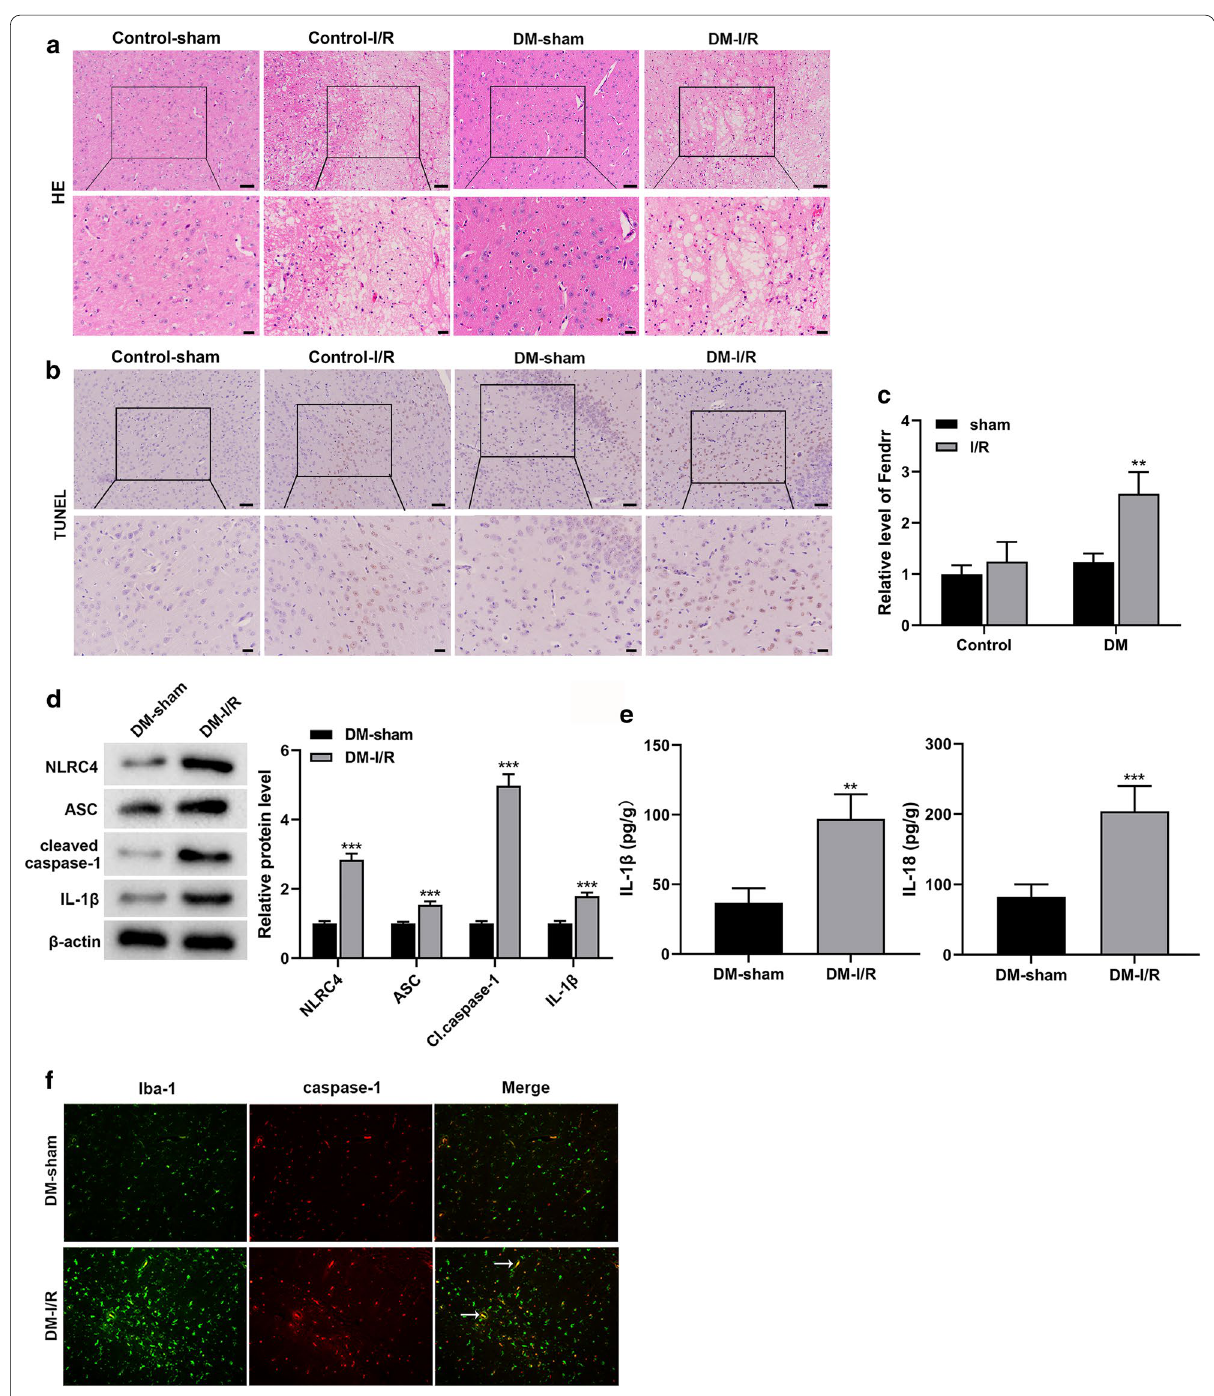
Fig. 1 LncRNA‑Fendrr and NLRC4‑mediated inflammation is activated in the brain tissues of diabetic cerebral ischemia/reperfusion injury mice. The model of cerebral ischemia/reperfusion (I/R) injury in mice was established, and mice were divided into the DM‑I/R group and the DM‑sham group (control), n 10/group. a HE staining was used to detect pathological changes in mouse brain tissue. Scale bar in the top line is 50 μm, and = the bottom line is 20 μm. b TUNEL staining was used to detect neuronal apoptosis in mouse brain tissue. Scale bar in the top line is 50 μm, and the bottom line is 20 μm. c The expression of lncRNA‑Fendrr was detected by qRT‑PCR. d NLRC4, ASC, cleaved caspase‑1 and IL‑1β protein levels were detected by Western blotting. e The levels of IL‑1β and IL‑18 in brain tissue homogenate were detected by ELISA. f Detecting microglia markers Iba‑1 and caspase‑1 in the brain tissue of mice by Immunofluorescence (n 3/group). Data are presented as means SD. P values were analyzed by = ± Student’s t‑test. ** P < 0.01 and *** P < 0.001 versus the DM‑sham